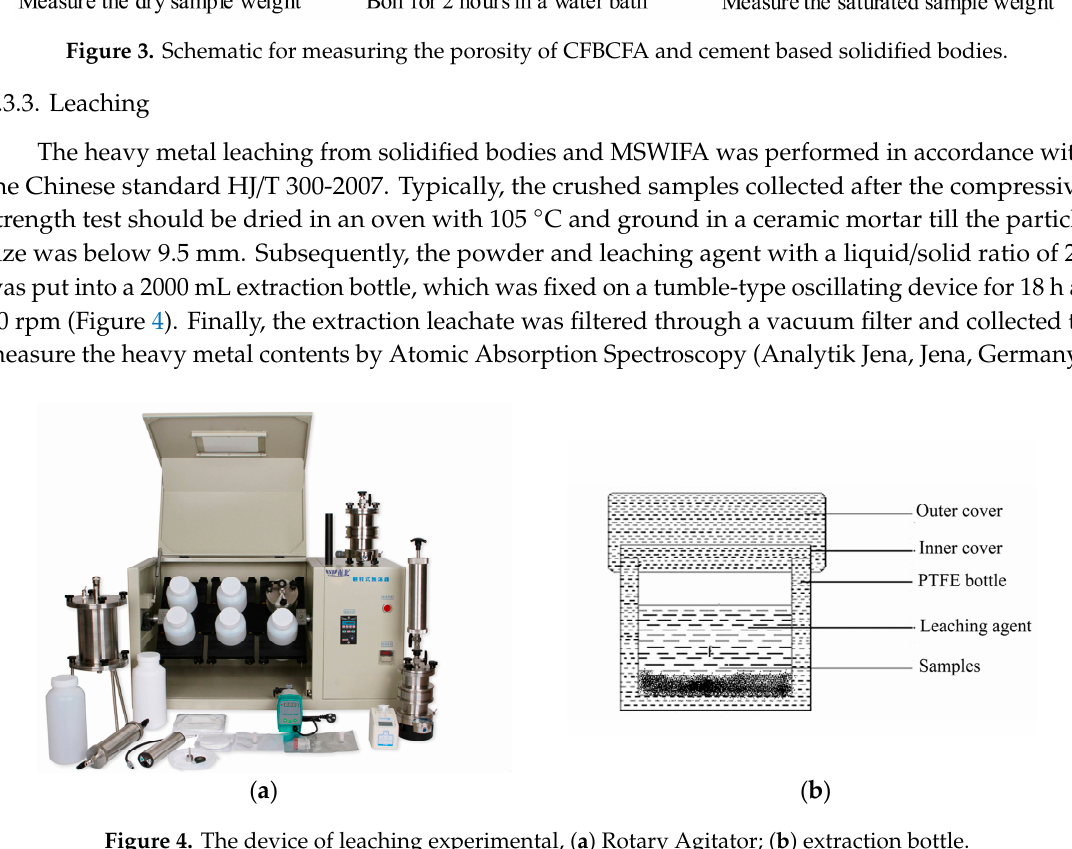
Figure 4. The device of leaching experimental, ( a ) Rotary Agitator; ( b ) extraction bottle.